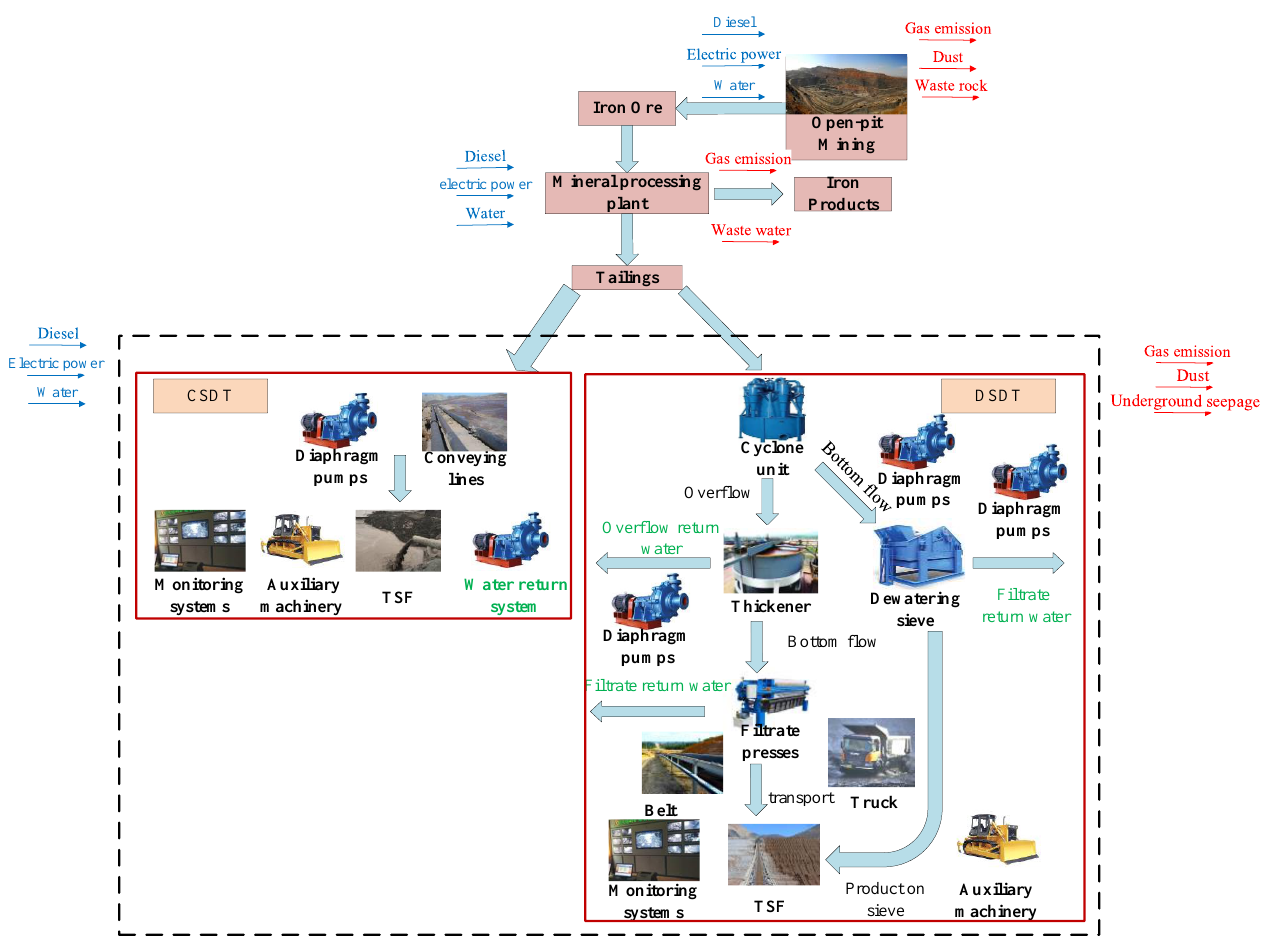
Figure 3. System boundary for cradle-to-gate LCA of the iron mine in northern China.